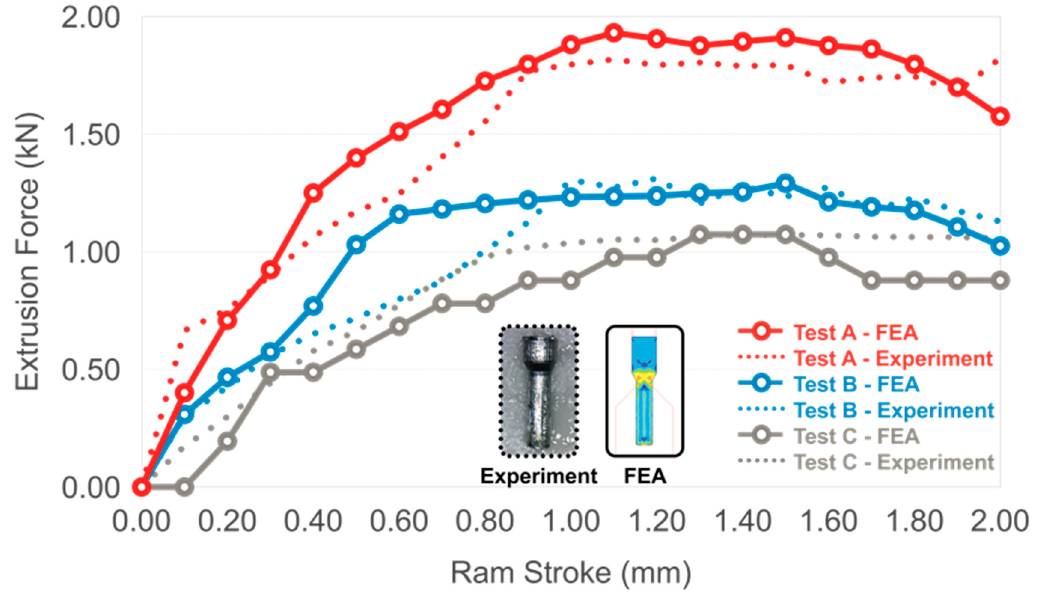
Figure 4. The results comparison between the experimental and FE micro-extrusion tests by using the 66- μ m grain-size billets under different friction conditions.